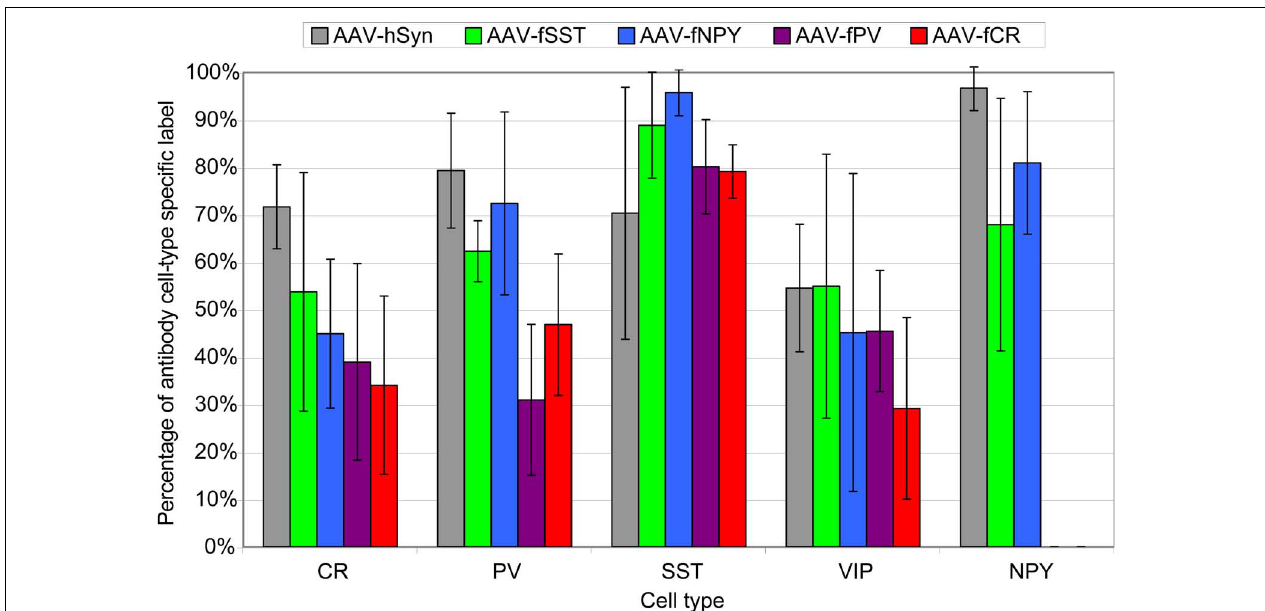
the injected region. The percentages refl ect the combined labeling in cortical layers 2/3–6 and the standard deviations show the labeling distributions treating each section as an independent observation. Sections were counted from a single animal for AAV-fPV, and from three animals for all others. NPY label was not counted for AAV-fPV and AAV-fCR. At least 170 cells were counted for each vector/antibody combination (see Materials and